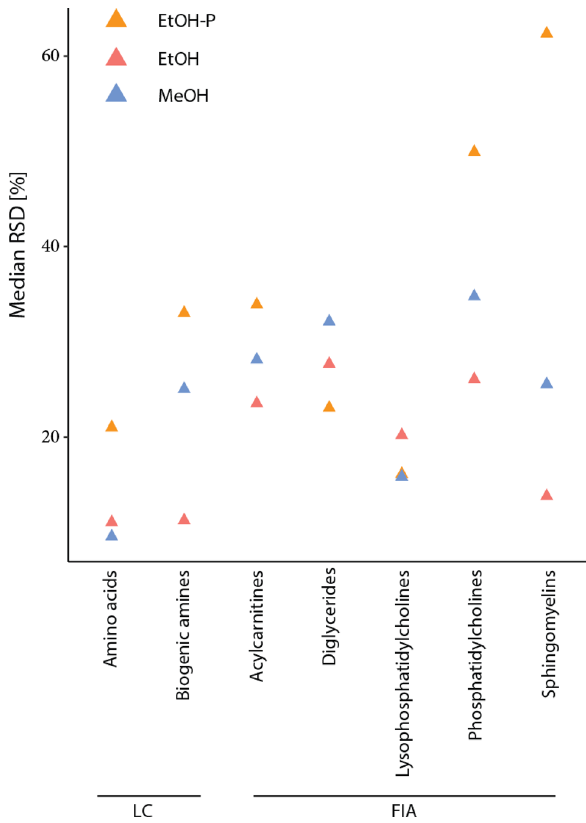
Figure 3. Results of an analysis of HOS cells using the Biocrates p400 HR kit using different cell lysis extraction solvents. Median relative standard deviation (RSD) of the individual compounds per biological group. Both liquid chromatography (LC) and flow injection analysis (FIA) mass spectrometry measurements are shown. Five replicates were measured in each condition; outliers were removed from the final analysis as described in the materials and